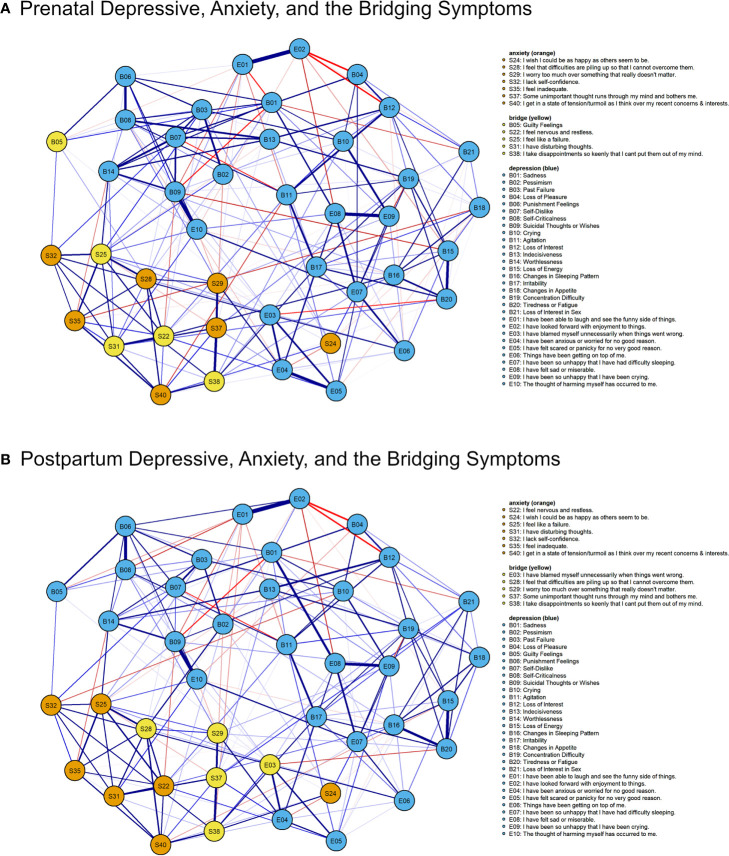
Symptoms that bridged maternal depression and anxiety in the prenatal (A) and post-partum (B) networks. Only the five symptoms with strongest bridge EI are shown.